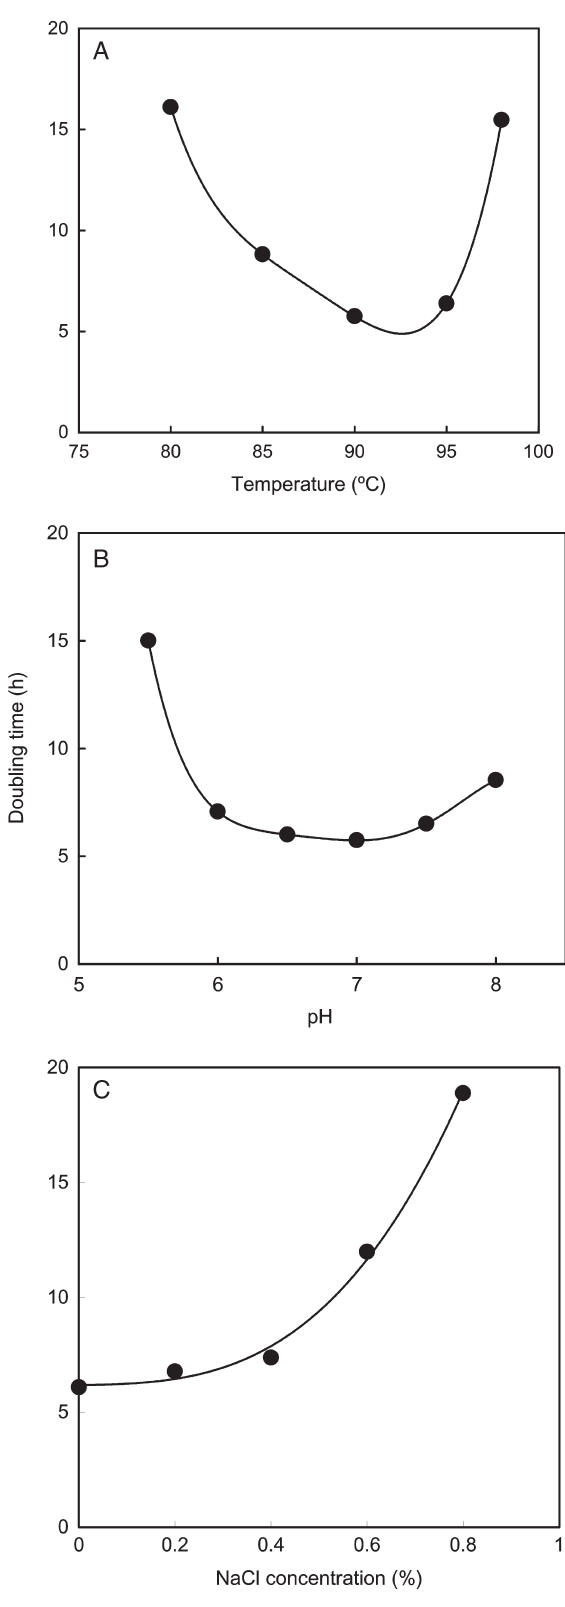
Figure 3. Effect of temperature (A), pH (B) and NaCl concentration (C) on aerobic growth of isolate VA1 in TY medium. Doubling times were calculated from the slopes of the growth curves (not